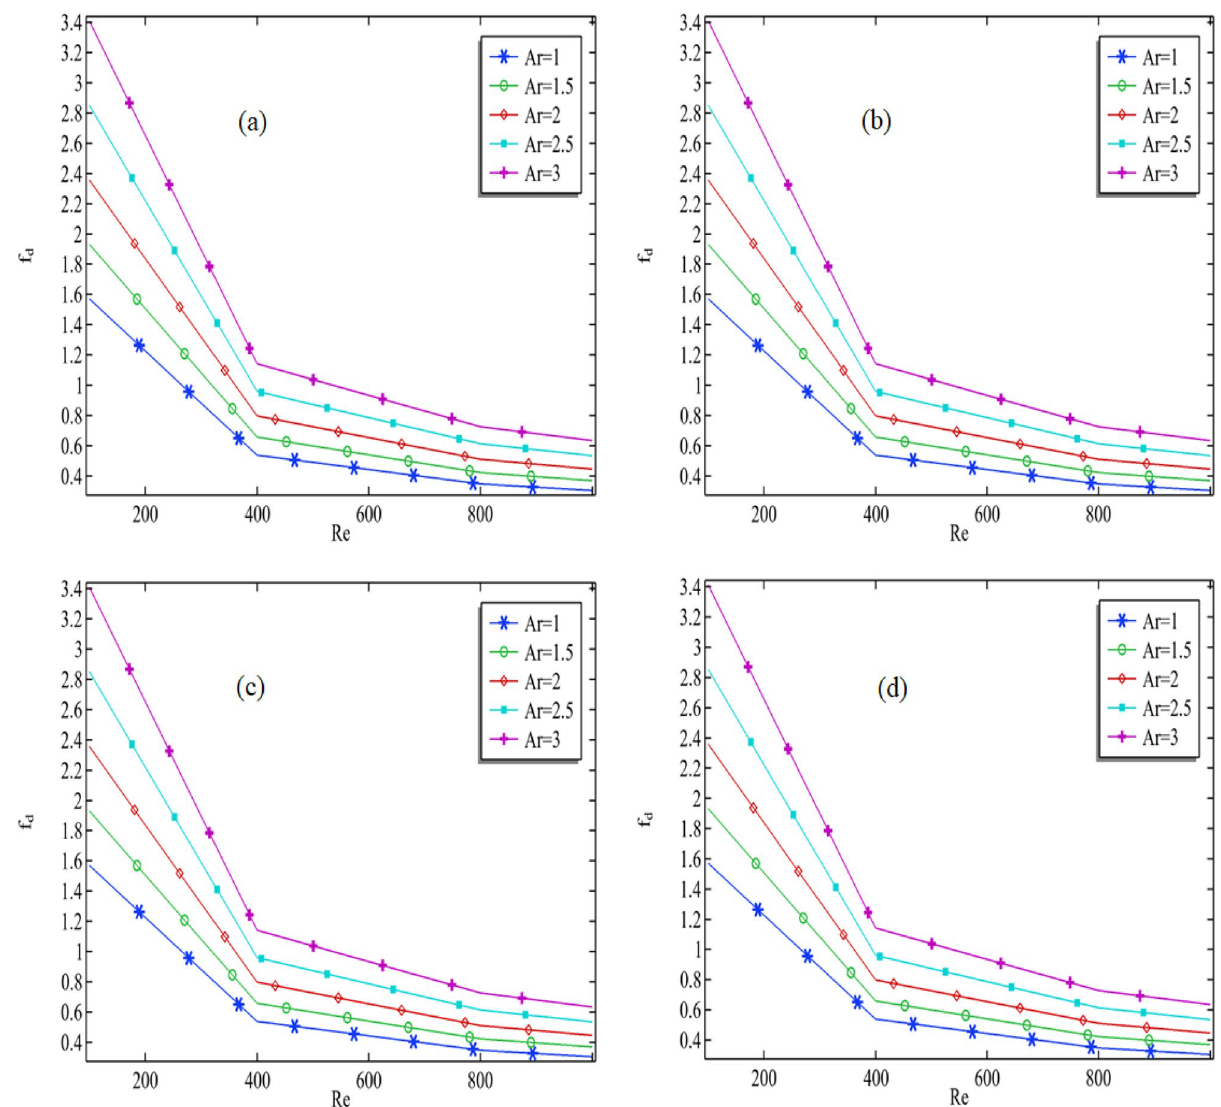
Figure 9. The numerical results for the Darcy–Welsbach friction factor in the whole